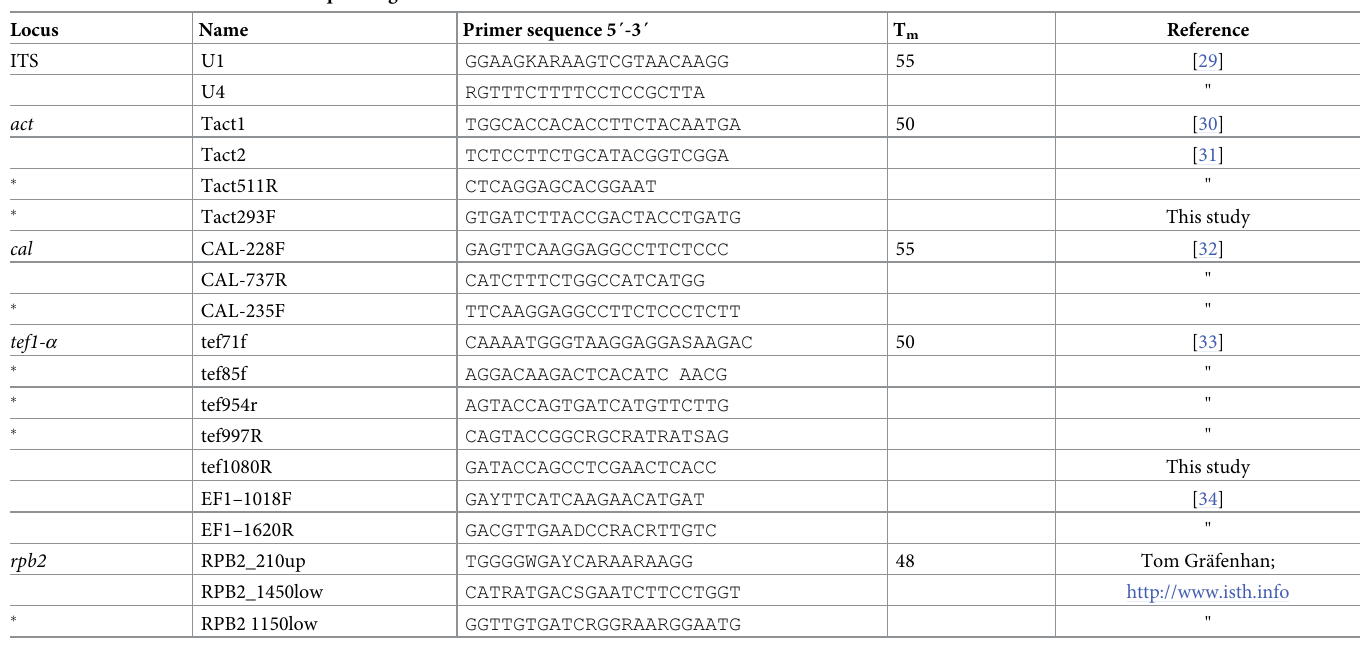
Table 2. Primers used for PCR and